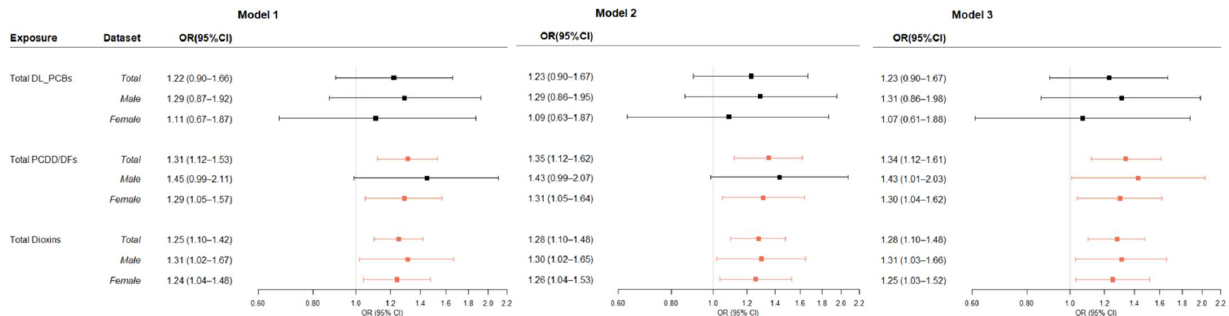
Figure 3. Odds Ratios of blood concentrations of PCDD/DFs, DL-PCBs (pgTEQ/g_lipid) and Thyroid Cancer. OR, odds ratio; CI, confidence interval. Model 1: Adjusted for age and sex; Model 2: Adjusted for the model 1 variables and body mass index; Model 3: Adjusted for the model 2 variables and thyroid stimulating hormone. Marked red based on statistically significant results.